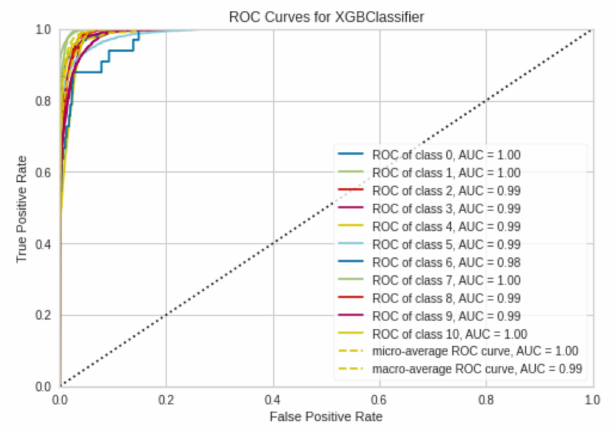
Figure 3. Receiver operating characteristic curves of the XGBoost classifier.